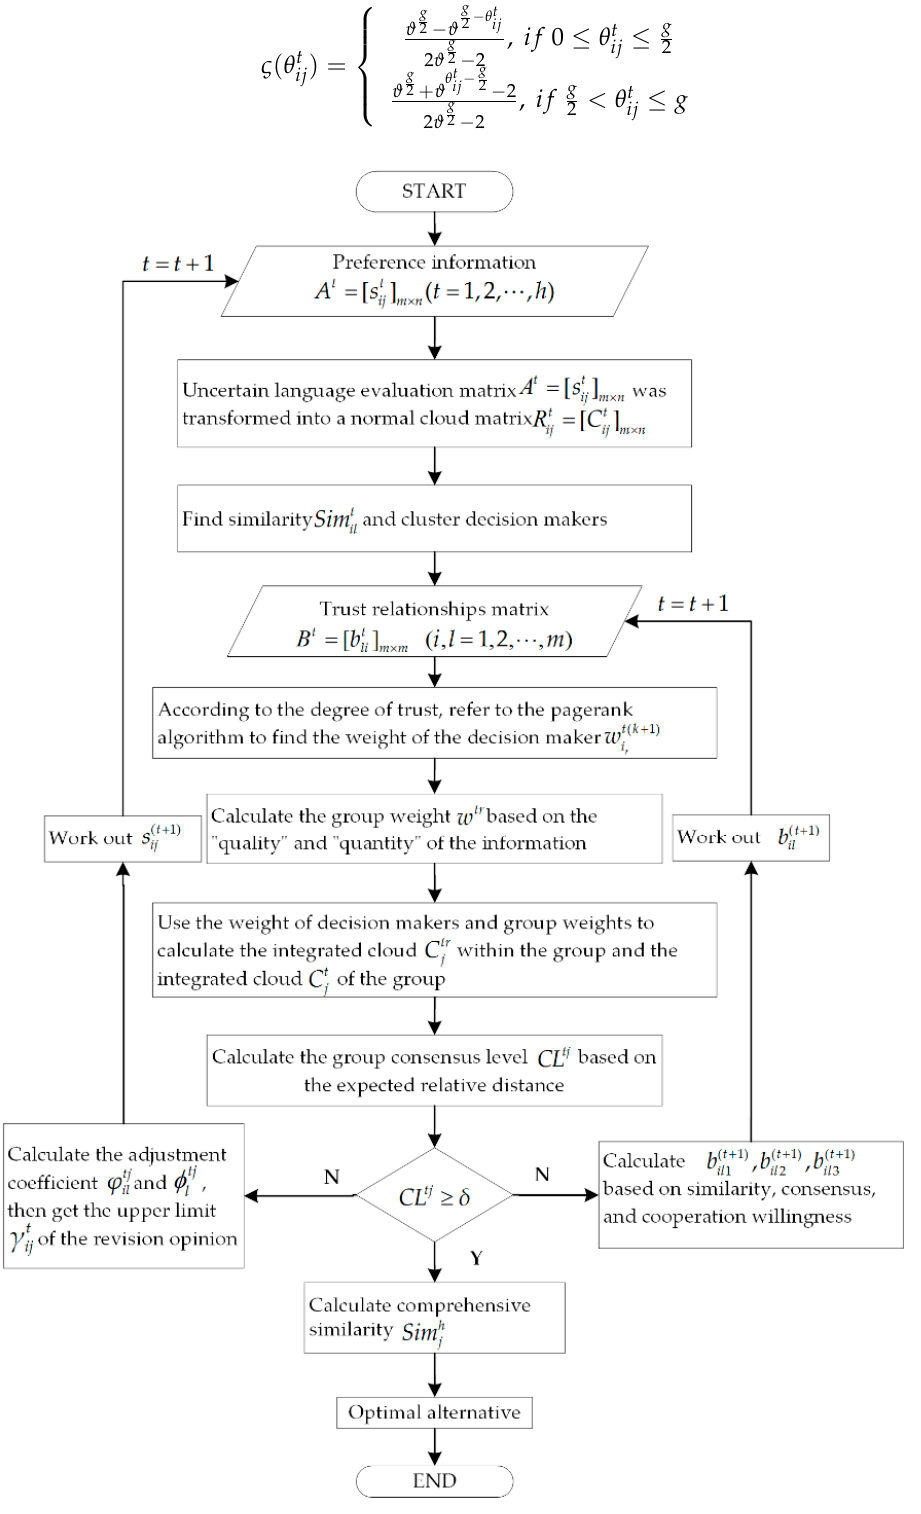
Figure 1. Large group decision-making process considering trust update.